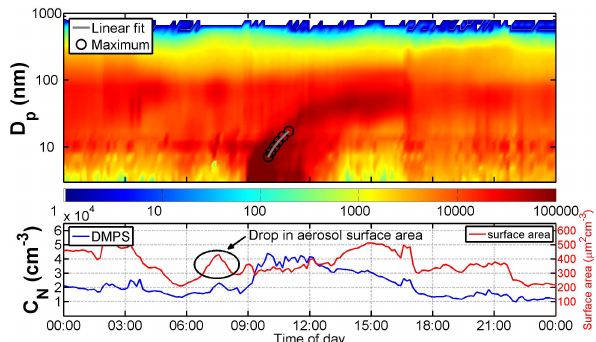
Fig. 7. Three month median number size distribution with three modes fitted to the data. Weekday (weekend) modal peaks of the nucleation, Aitken, and accumulation mode particles are at 18 (18), 50 (48) and 213 (206)nm, respectively. Weekday (weekend) median modal particle concentrations are 11500 (9400), 9300 (9000) and 610 (640)cm − 3 . The widths ( σ) of the mode fits are 1.83 (1.89), 1.89 (1.92) and 1.40 (1.40).